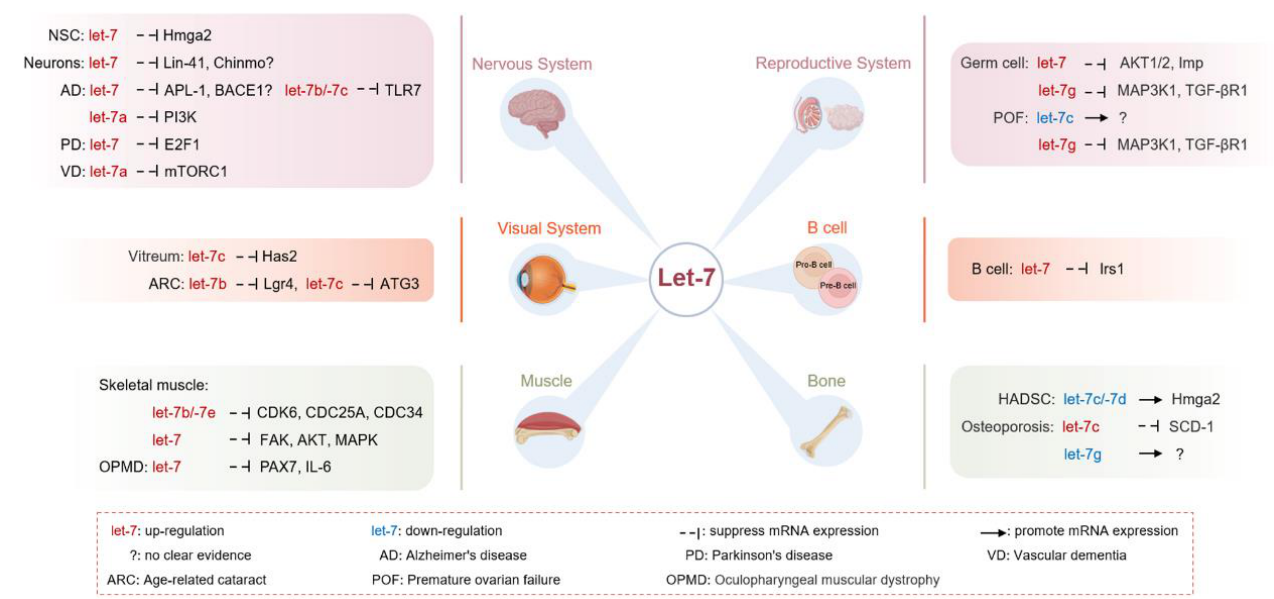
Figure 3. Target genes regulated by let-7 in aging and aging-related diseases in multiple tissue systems.